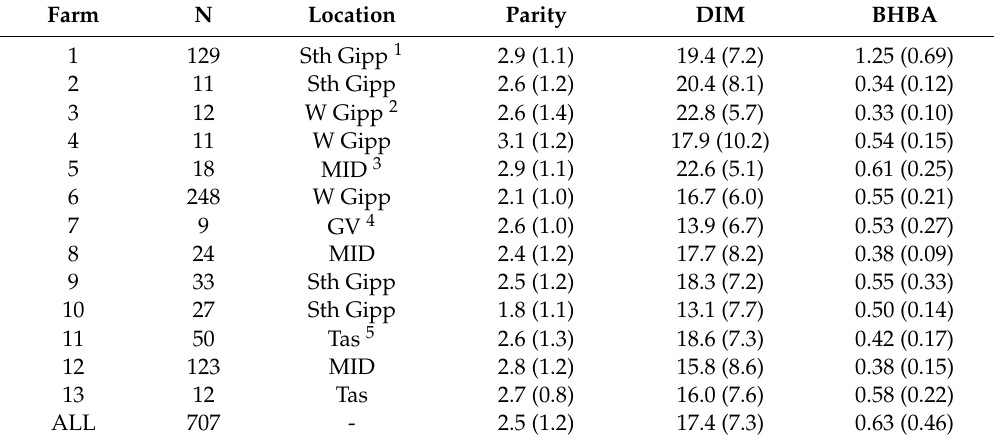
Table 1. Descriptive statistics of dataset used in this experiment, including farm details, number of cows (N), mean and standard deviation (shown in parentheses) of parity, days in milk (DIM), and serum β hydroxybutyrate (BHBA) concentrations obtained from dairy cows in the first 30 days of lactation from 13 farms in south eastern